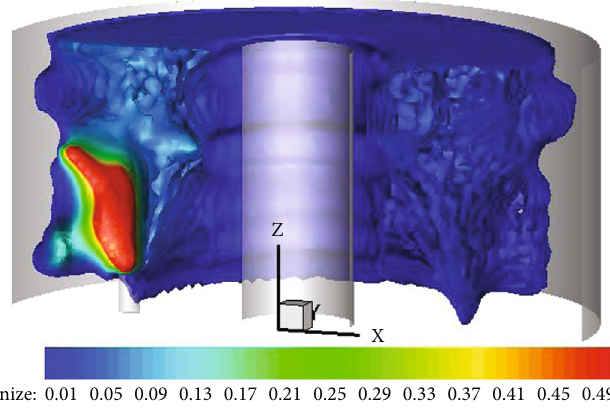
Figure 17: Distribution of Bohm, elasticity, excitation, and ionization collision with 6 times the initial magnetic fi eld